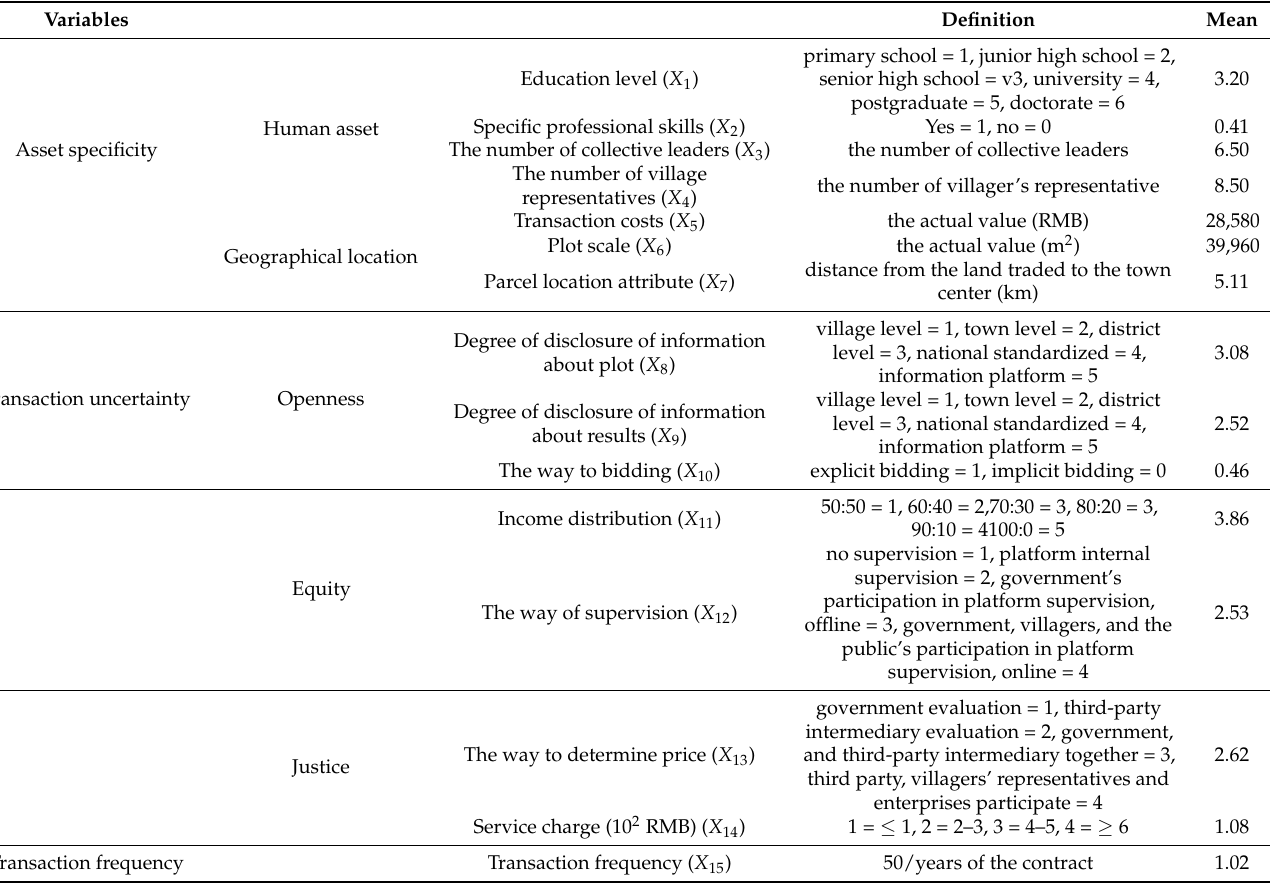
Table 1. The definition of variables and description of